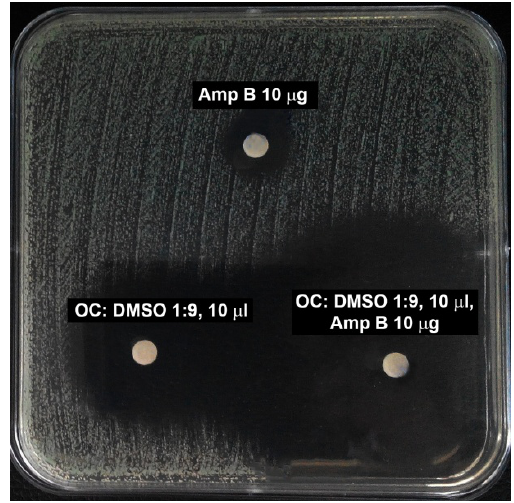
Figure 4. Synergistic action of amphotericin B with cinnamon oil (upper disc 10 μ g of amphotericin B alone, bottom left 10 μ L of cinnamon oil alone diluted 10 times with DMSO (dimethyl sulfoxide), bottom right AmB and EO in combination). DMSO alone does not show the inhibitory zone.